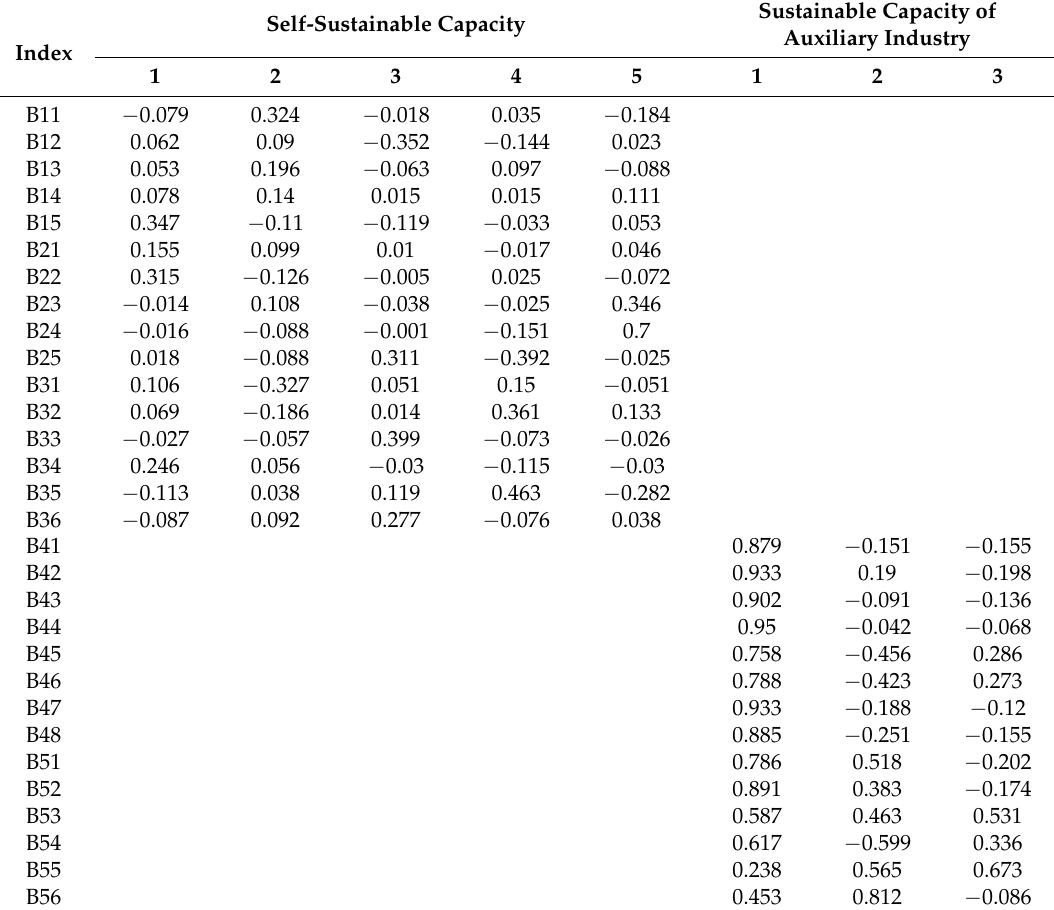
Table 4. Component Score Coefficient